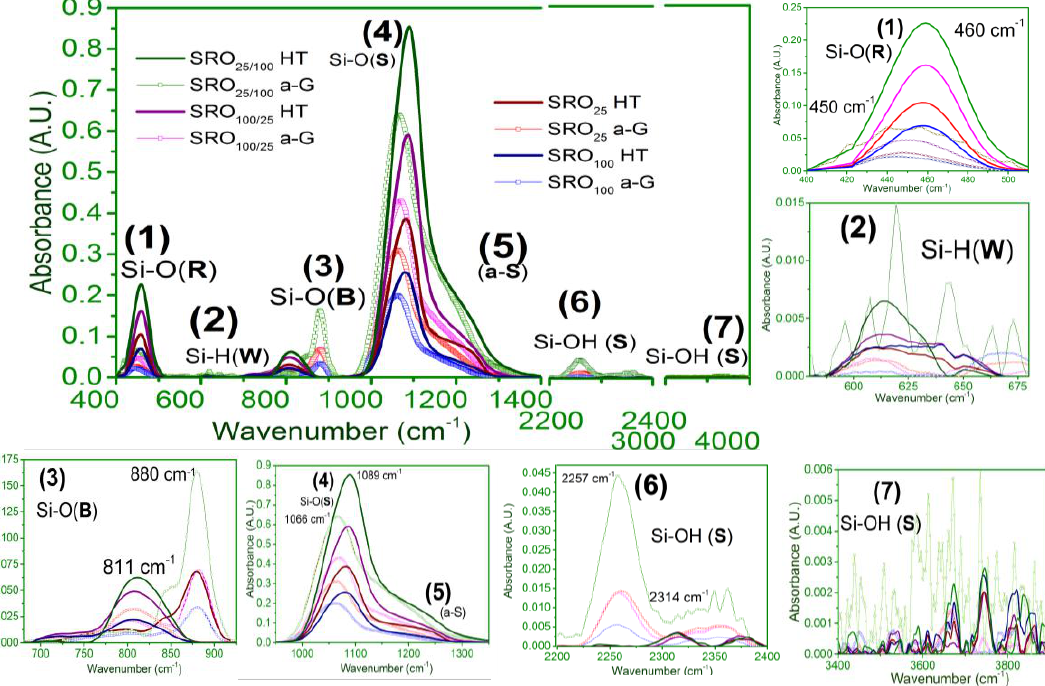
Figure 5. Spectra of the FTIR of the SR0 25 , SRO 100 , SRO 25 / 100 , and SRO 100 / 25 films, as-G and HT deposited on silicon substrates.